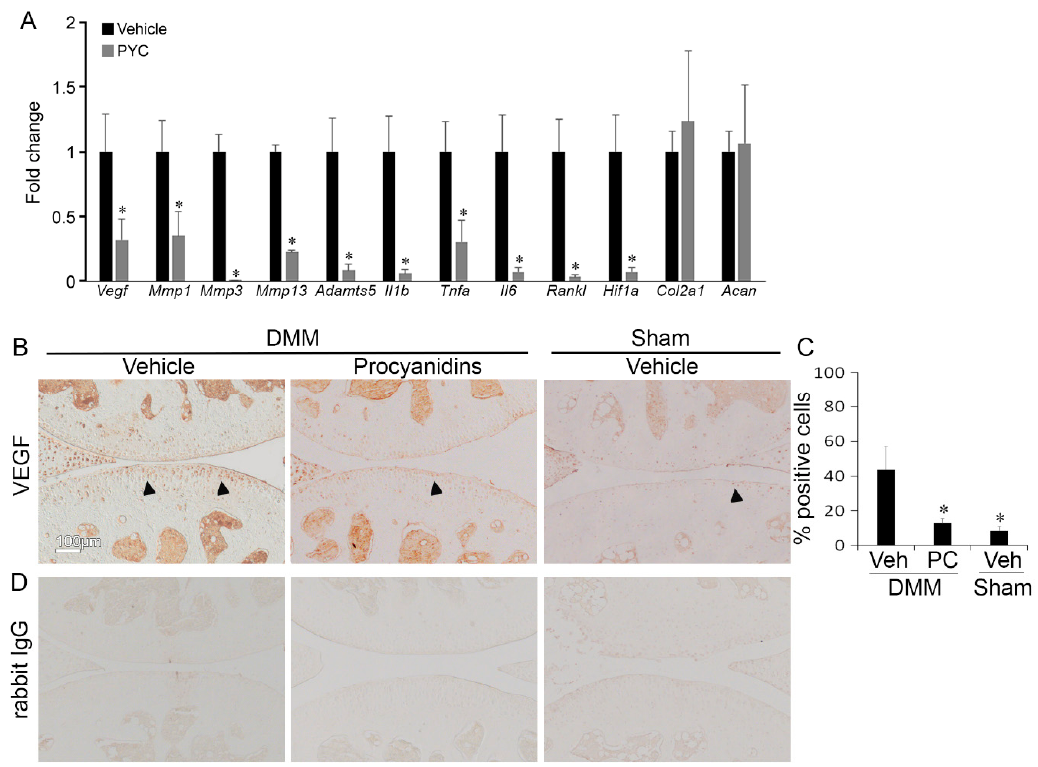
Figure 4. Oral administration of procyanidins suppressed expression of vascular endothelial growth factor (VEGF) and genes that may be regulated by VEGF and are involved in osteoarthritis (OA) pathogenesis in articular cartilage of mice subjected to DMM surgery. ( A ) Relative mRNA levels of Vegf , Mmp1 , Mmp3 , Mmp13 , Adamts5 , interleukin (Il)1b tumor necrosis factor α ( Tnfa ), Il6 , receptor activator of nuclear factor kappa-B ligand ( Rankl ), and hypoxia-inducible factor ( Hif)1a in articular cartilage of mice subjected to DMM treated with procyanidins were significantly reduced compared to that in mice subjected to DMM and treated with vehicle; ( B , C ) immunohistochemistry and quantification of chondrocytes expressing VEGF (* p < 0.05, t -test, n = 4/group); ( D ) representative staining of tissue sections with isotype control (rabbit immunoglobulin G (IgG)). * p < 0.05 by one-way ANOVA with Tukey post-hoc test; n = 4/group. Arrows indicate representative chondrocytes with positive staining for VEGF.